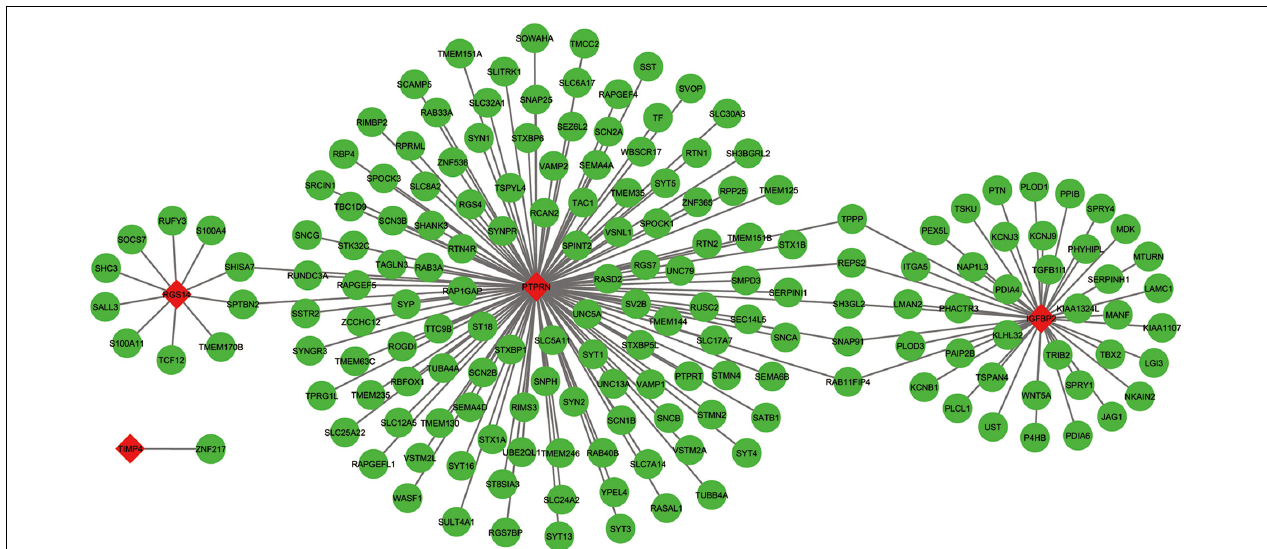
FIGURE 7 | The co-expression network of the five-gene signature. Red diamonds showed the key genes and green nodes are genes which co-expressed with the key genes.